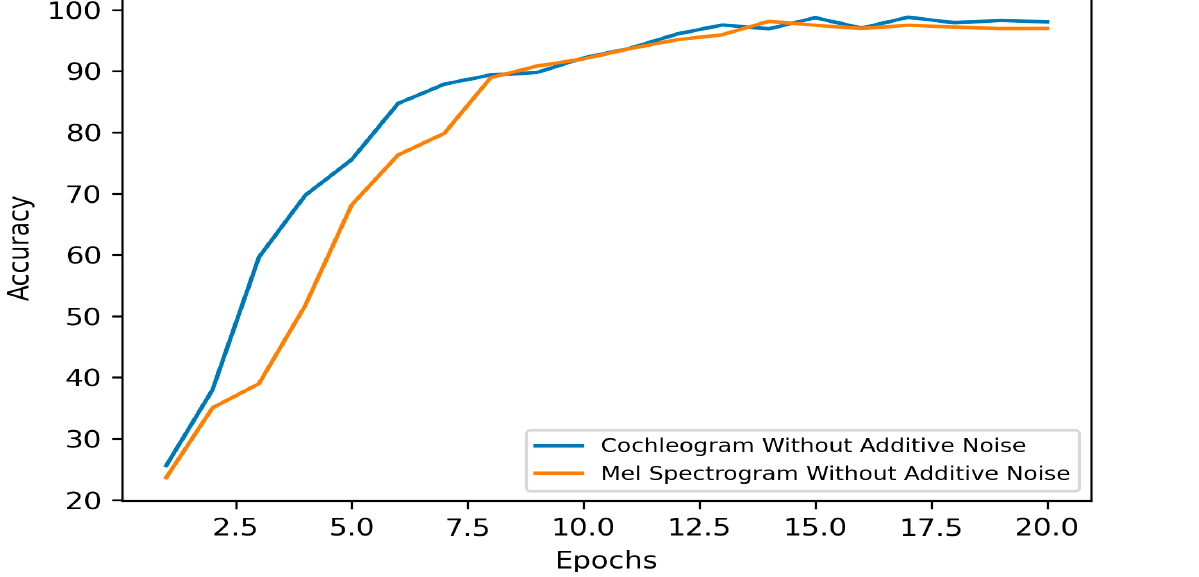
Figure 7. Speaker Identification Accuracy of Cochleogram vs. Mel Spectrogram at Medium Noise Ratio using VGG-16 Architecture.